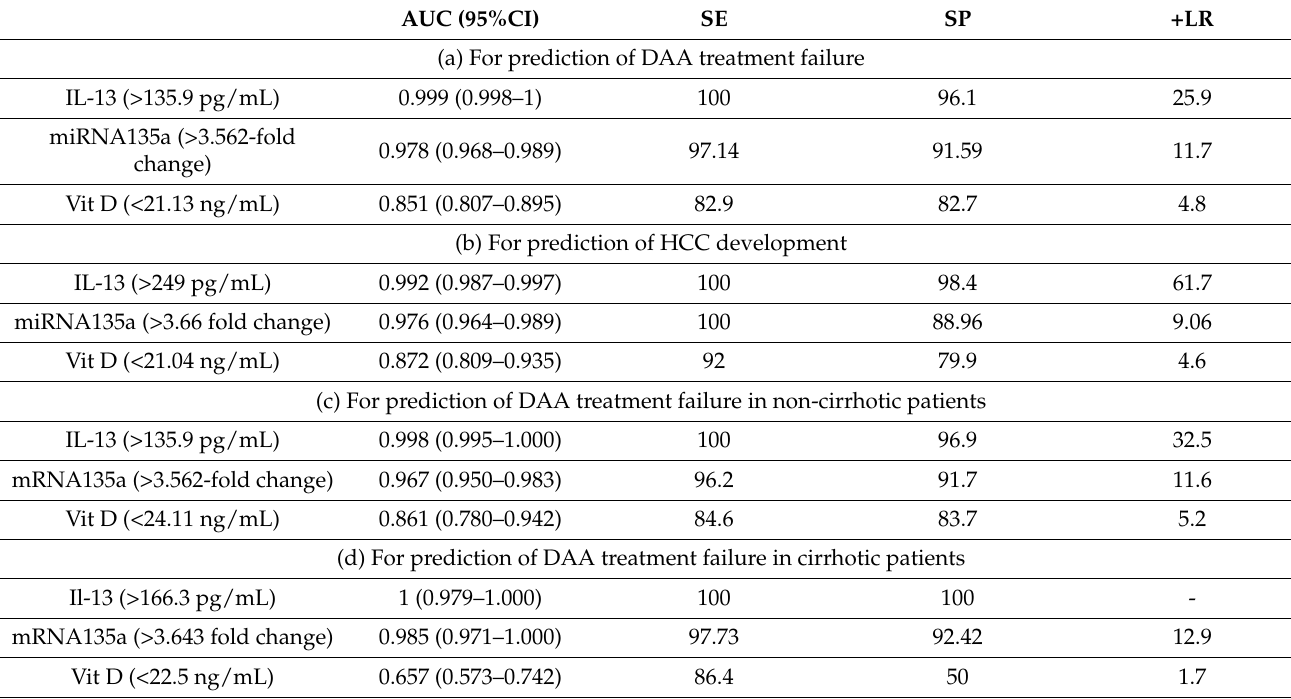
Table 3. Diagnostic accuracy of IL-13, miRNA-135a, and vit D to predict treatment failure and HCC with the best predictive cut